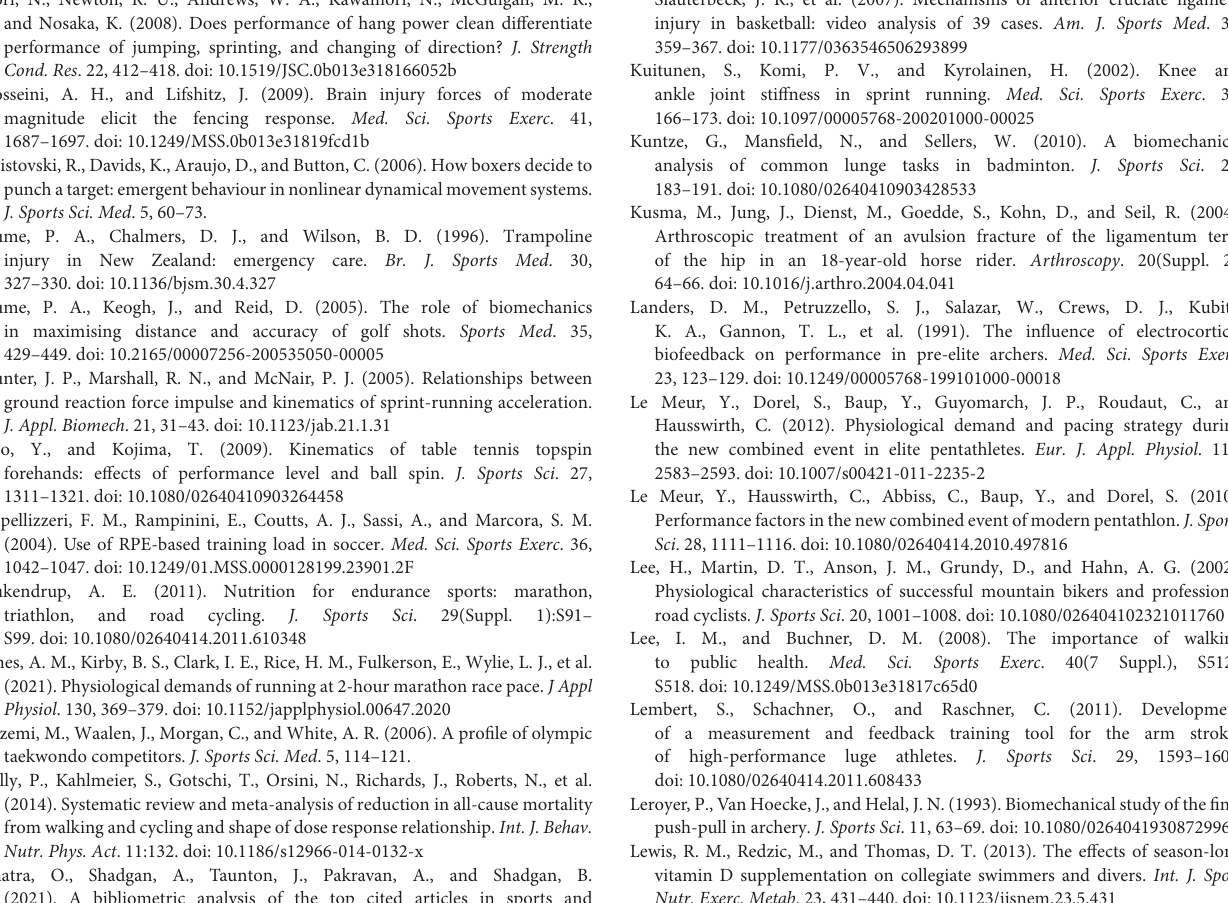
table tennis: a review. J. Sports Sci. Med . 12, 362–370. Kraemer, W. J., Fry, A. C., Rubin, M. R., Triplett-McBride, T.,